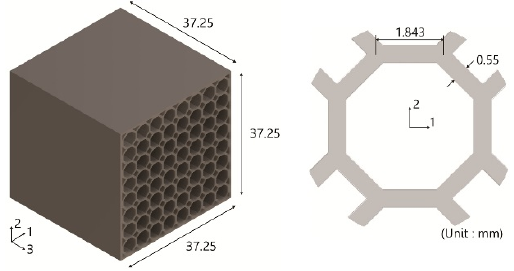
Figure 6. Dimensions of the anisotropic structures.